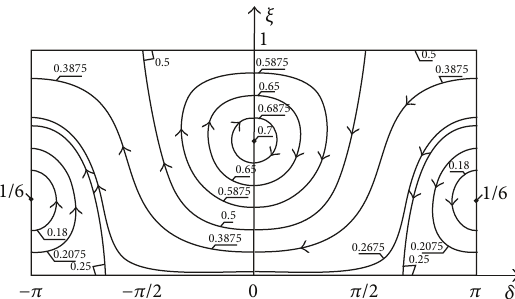
Figure 9: Phase portrait for the case of 1:1 internal resonance 𝜔 1 = 𝐾 (𝑏𝐸 ) −1 = −1 and 𝐾 𝜔 3 at 2 0